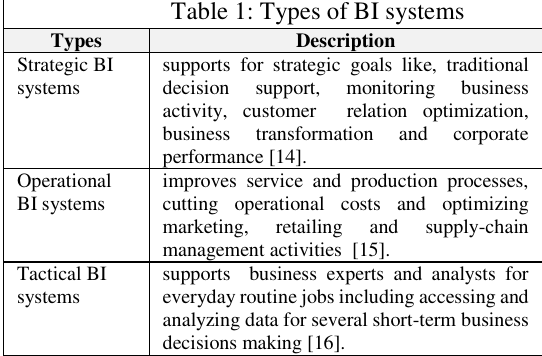
Table 1: Types of BI